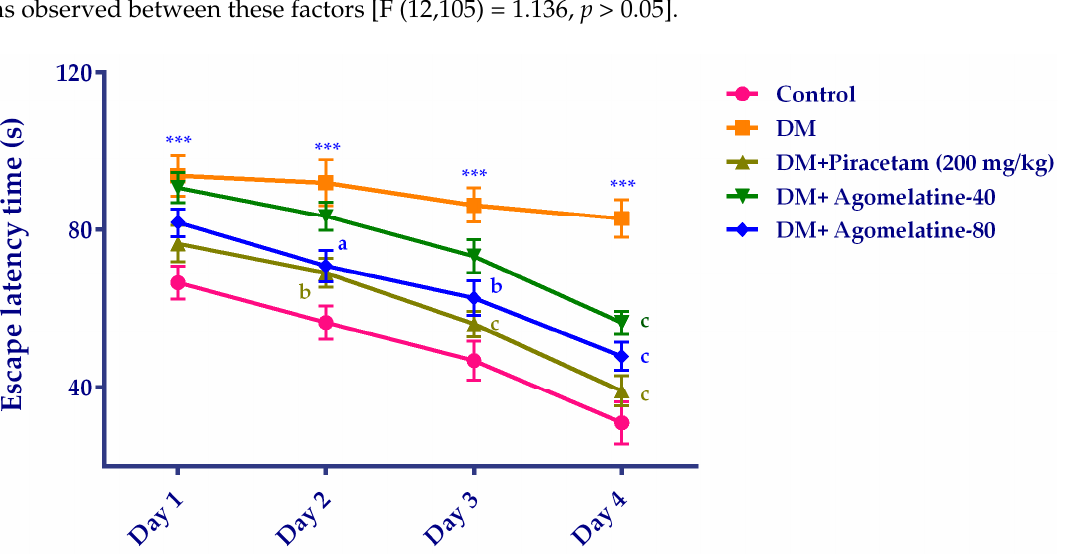
Figure 2. Escape latency time of normoglycemic rats administered saline solution (control) and diabetic rats administered saline (DM), 200 mg/kg piracetam, 40 mg/kg agomelatine or 80 mg/kg agomelatine for 2 weeks, in the Morris Water Maze (MWM) test. Values are given as mean ± S.E.M. Significant difference against corresponding control group *** p < 0.001; Significant difference against corresponding DM group a p < 0.05, b p < 0.01, c p < 0.001. Two-way repeated-measures ANOVA, post-hoc Bonferroni multiple comparison test, n = 8.